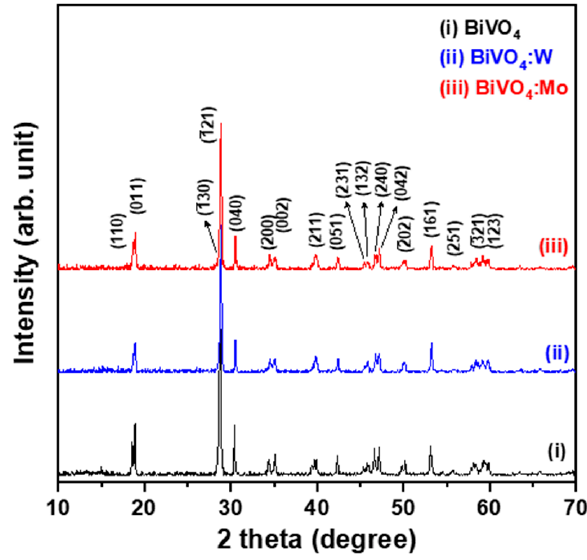
Figure 1. XRD patterns of BiVO 4 , W-doped BiVO 4 (BiVO 4 :W), and Mo-doped (BiVO 4 :Mo) nanoparticles synthesized using a hydrothermal method at pH 4.0.